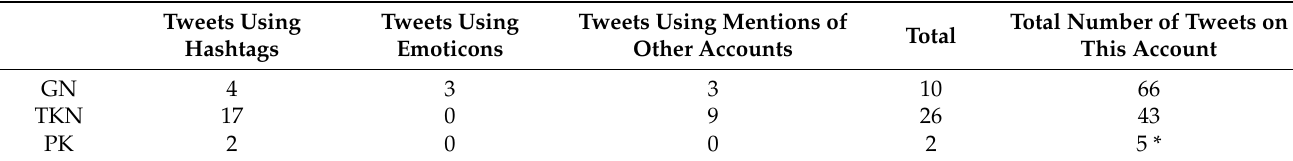
Table 6. The scope of enhancing posts by the Catholic weeklies’ profiles (N = 114). Tweets Using